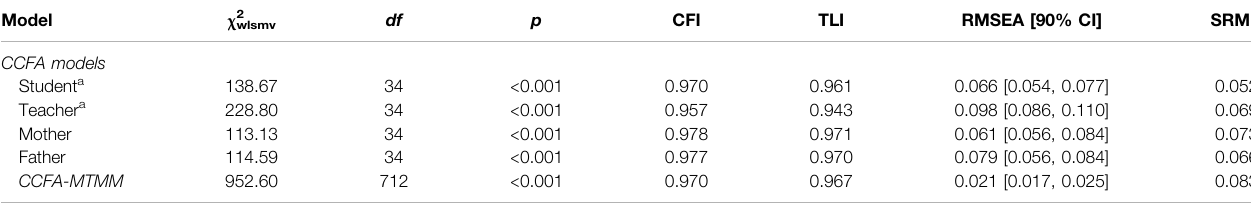
TABLE 5 | Summary of model fi t indices. Model